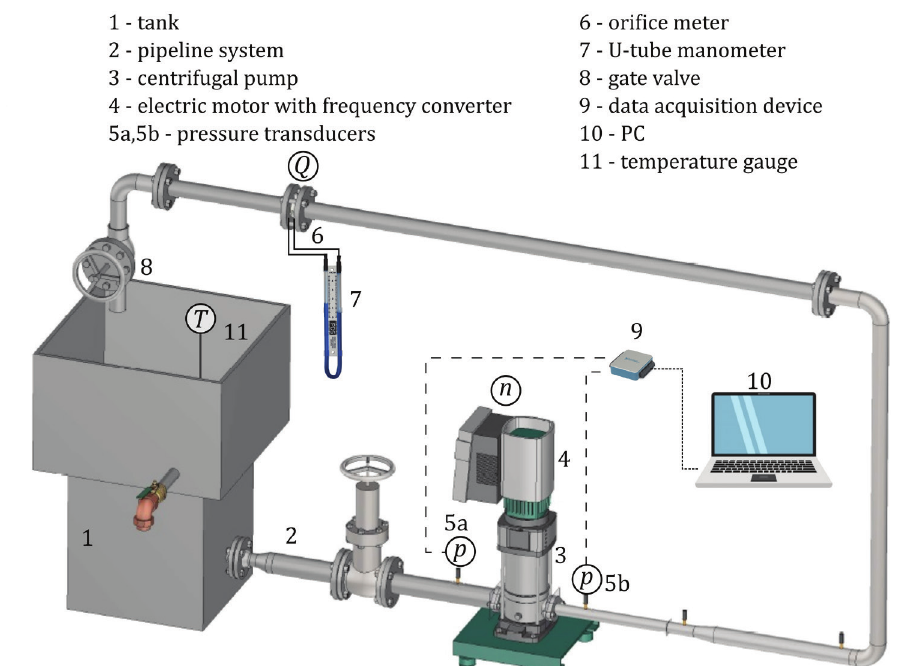
Fig. 2 – Experimental